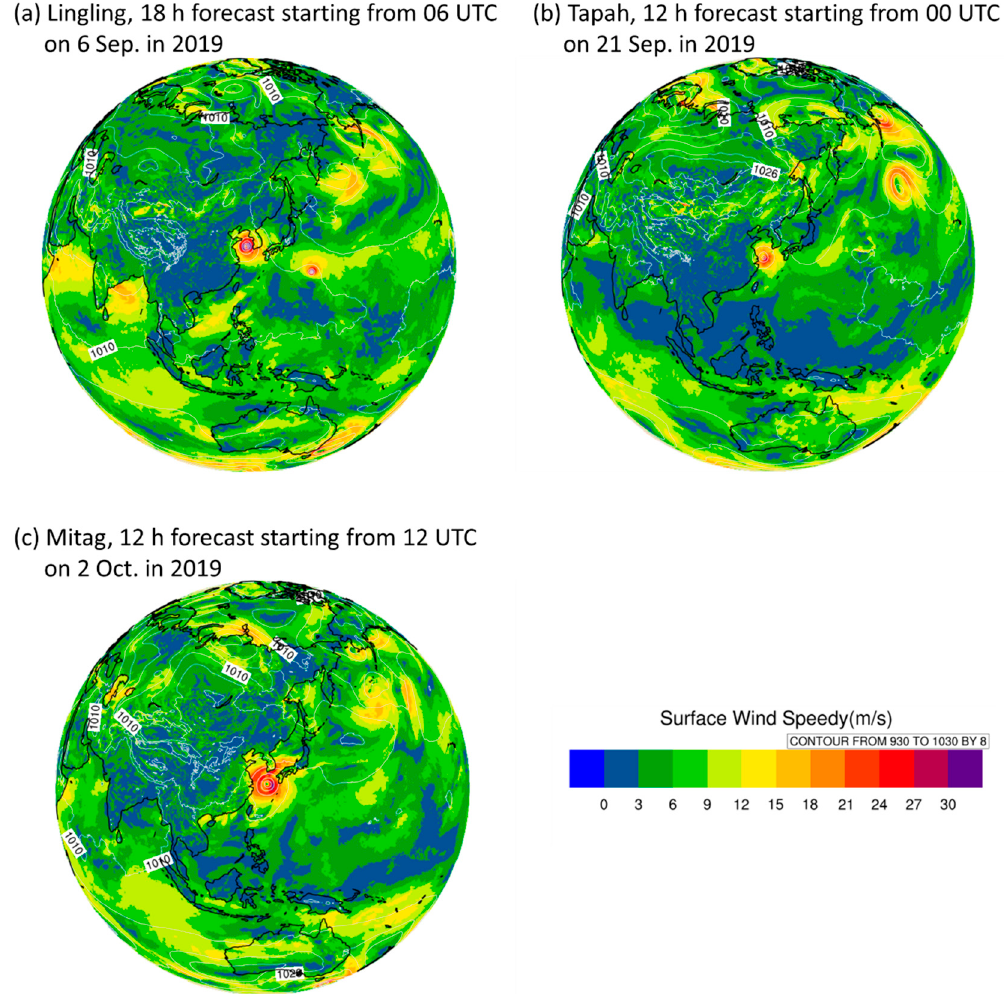
Figure 6. MPAS forecast of surface wind speed (m/s, shading) and sea-level pressure (hPa, contour) for ( a ) Lingling, ( b ) Tapah, and ( c ) Mitag.